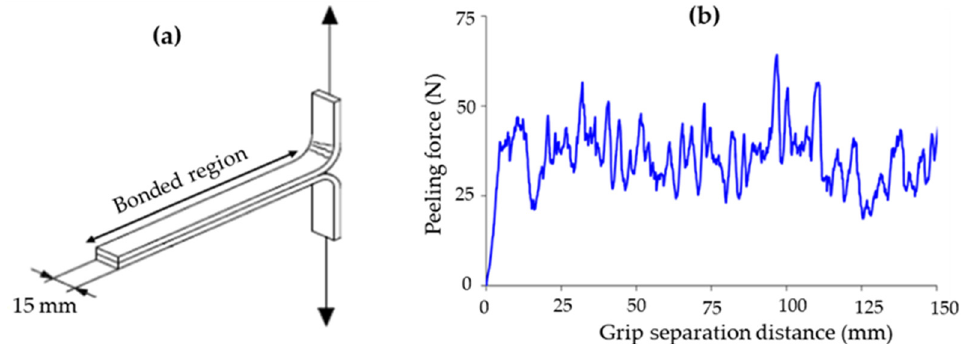
Figure 1. ( a ) Peeling test specimen geometry; and ( b ) the peeling test result of the two layered Flax/PP laminate.